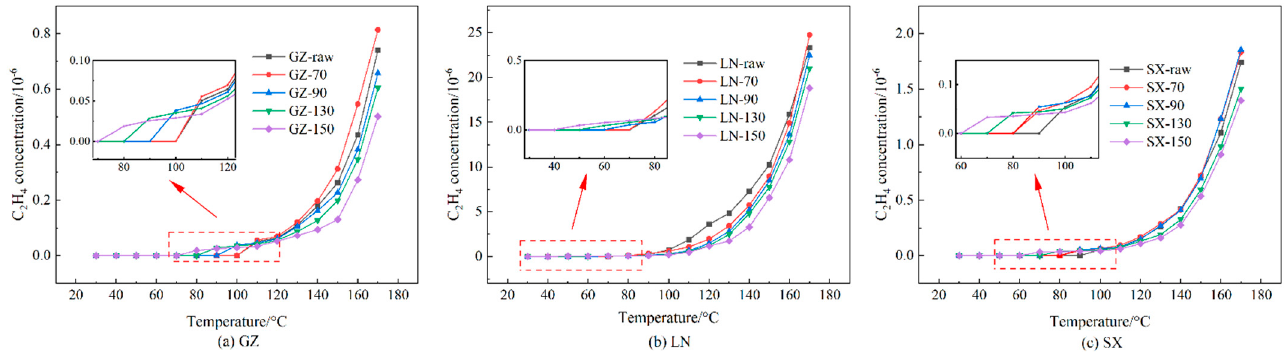
Figure 6. C 2 H 4 concentration at the outlet of the coal sample reactor: (a) GZ; (b) LN; (c) SX.